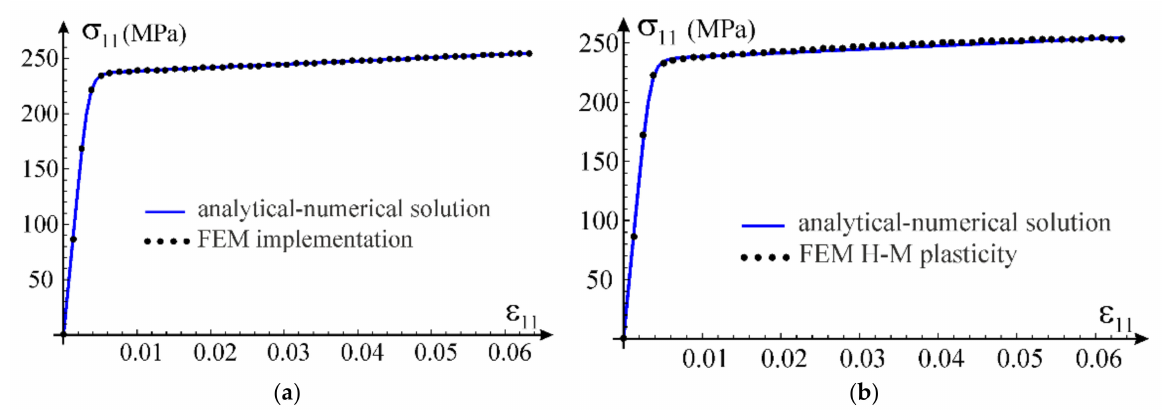
Figure 10. Comparison of the analytical-numerical nonlinear elastic solution for the uniaxial stress test with: ( a ) FEM solution according to own implementation, ( b ) FEM solution based on standard elastic-plastic model.